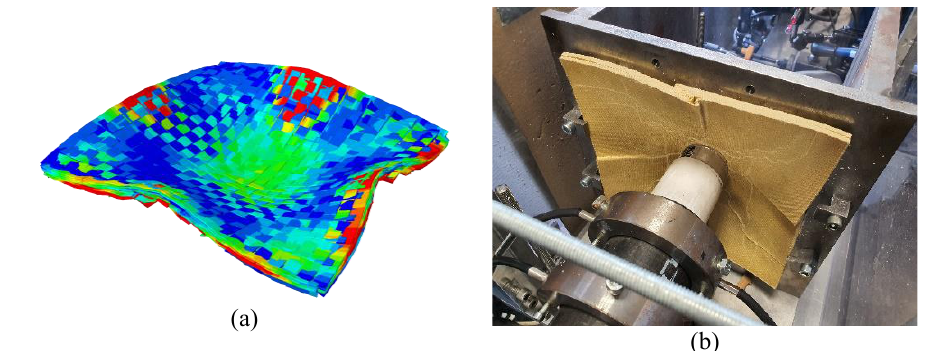
Figure 7 : Illustration of plate buckling (a) finite element model (b) experiment in